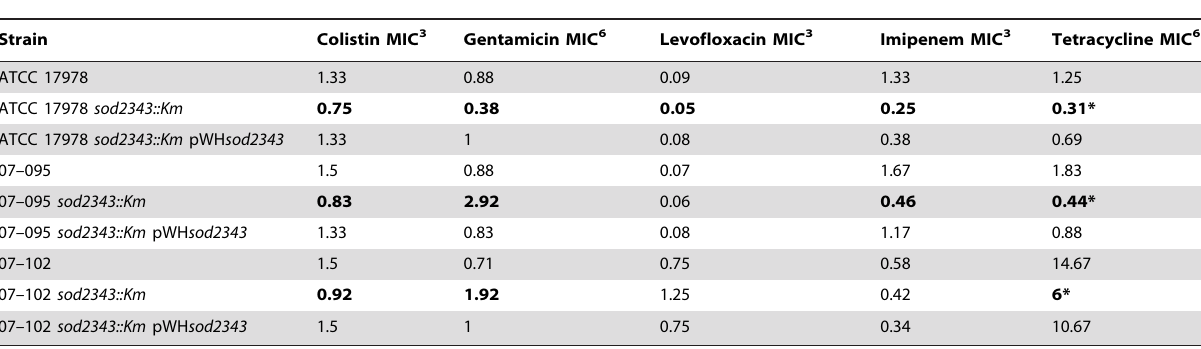
Table 2. Minimal inhibitory concentrations determined by Etest.